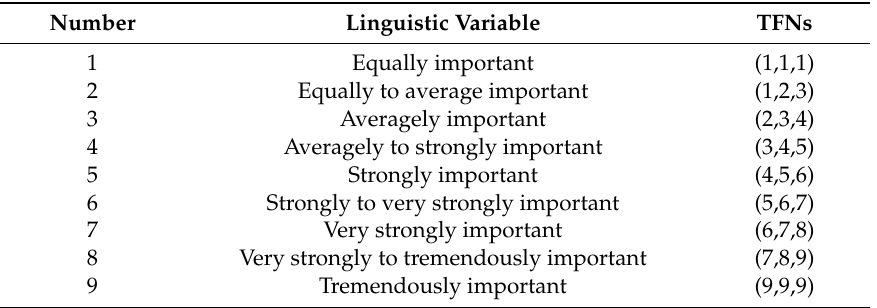
Table 4. TFNs Vcale [61].